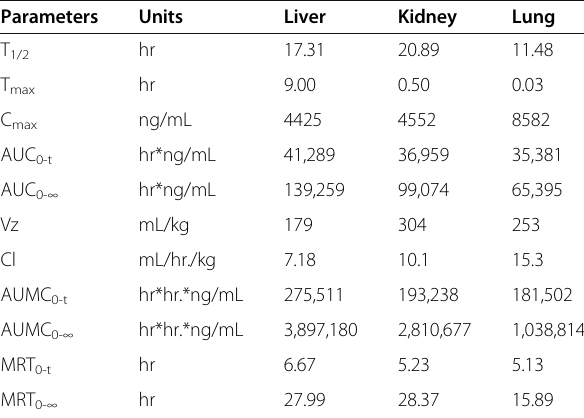
Table 2 Pharmacokinetic parameters of Emetine in liver, kidney, lung, plasma after intravenous administration of 1 mg/kg Emetine in mice ( n = 3) a Parameters